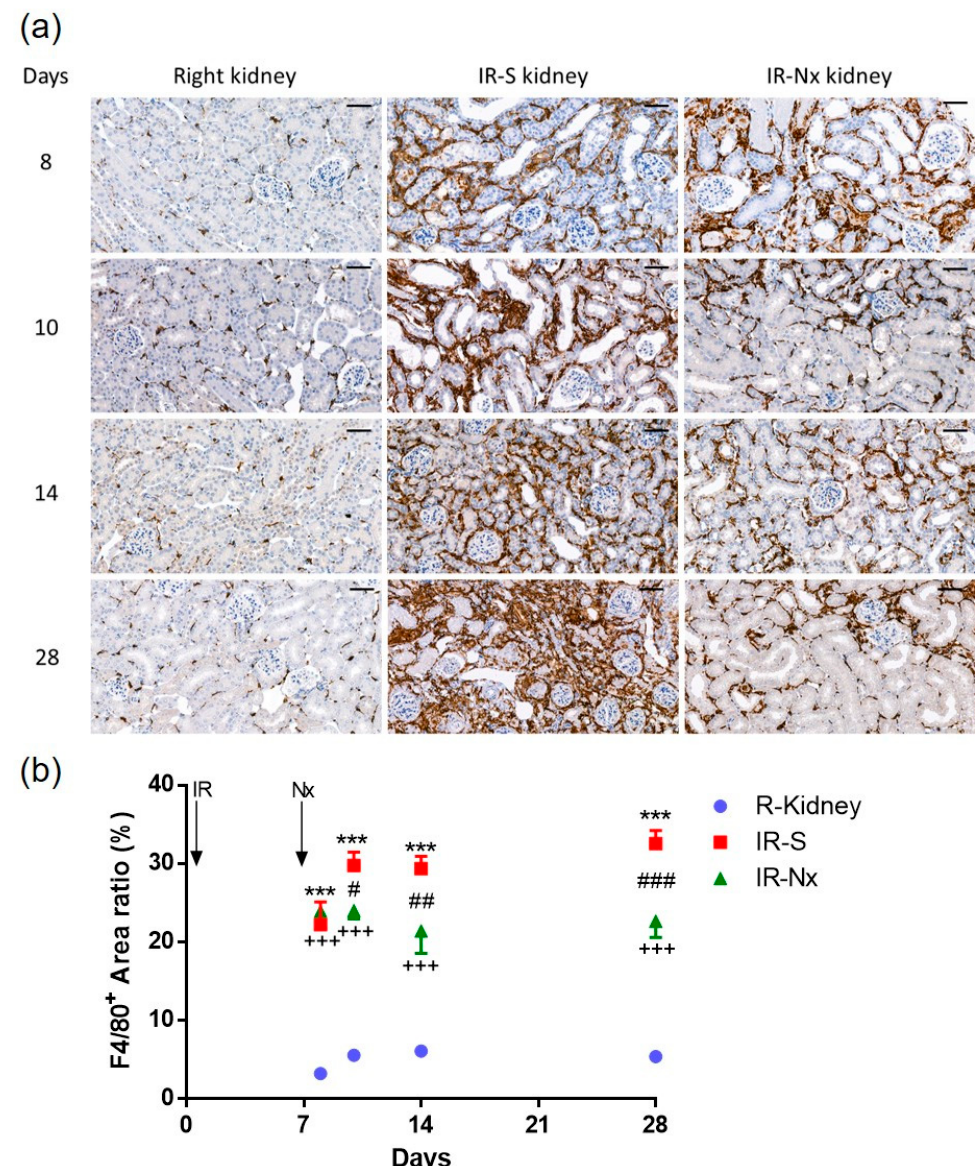
Figure 5. Macrophage-specific (F4/80) immunostaining of the kidney. Representative pictures of nonischemic right (left column) and postischemic left kidneys in the IR-S (middle column) and IR-Nx (right column) groups. ( a ) F4/80 staining (800x, scale bar: 50 μ m). ( b ) Positive staining per whole kidney area ratio. Two-way ANOVA with Tukey’s post hoc test. ***: p < 0.001 IR-S (red) vs. nonischemic right kidneys (blue); +++: p < 0.001 IR-Nx (green) vs. nonischemic right kidneys (blue), #: p < 0.05, ##: p < 0.01 and ###: p < 0.001 IR-S (red) vs. IR-Nx (green).